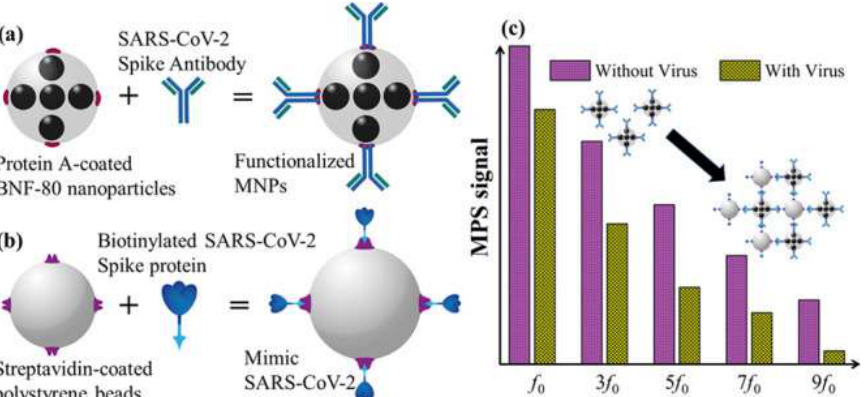
Figure 7. ( a ) Illustration of functionalized magnetic NPs; ( b ) illustration of SARS-CoV-2 mimic; ( c ) magnetic particle spectroscopy signal with and without SARS-CoV-2 mimic. Reprinted (adapted) with permission from Zhong et al, Toward Rapid and Sensitive Detection of SARS-CoV-2 with Functionalized Magnetic Nanoparticles. ACS Sens. 2021 , 6 , 976–984, doi:10.1021/acssensors.0c02160. Copyright 2021 American Chemical Society.